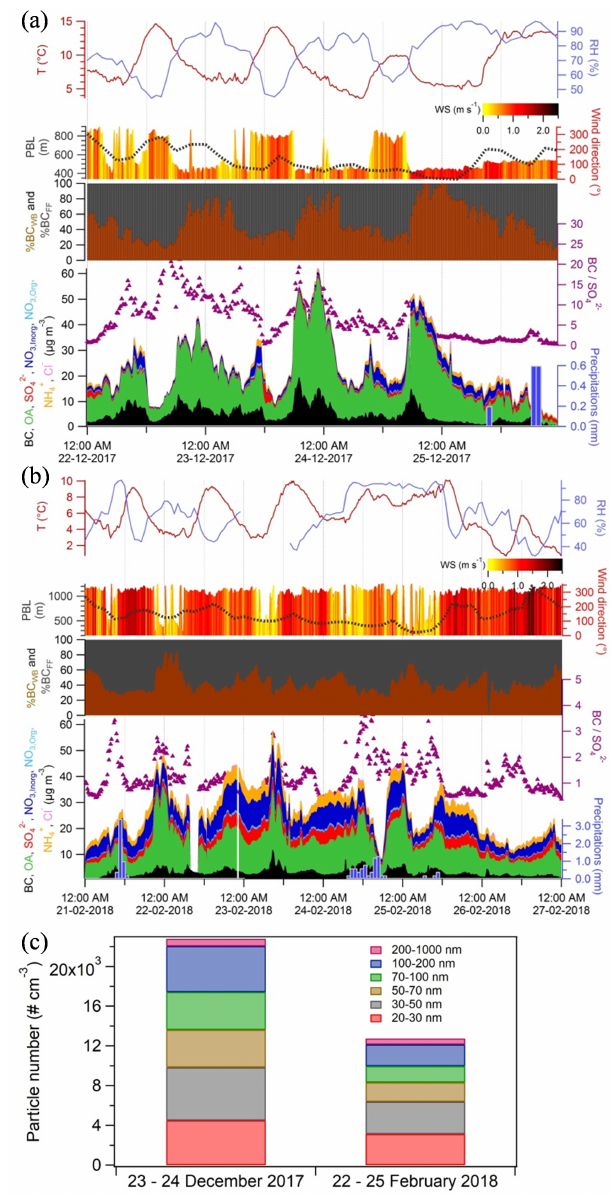
Figure 7. Time series of meteorological conditions and chemical composition during the two polluted episodes: the local Christmas event (23–24 December 2017) (a) and the long-range event (22– 25 February 2018) (b) . The chemical composition of submicron particles (Cl − , NH + , NO 3 , Org , NO 3 , Inorg , SO 2 − , OA and BC), the 4 4 relative contribution of BC FF and BC WB , the BC / SO 2 − ratio, and 4 the meteorological data (temperature, relative humidity, wind di- rection and speed, planetary boundary layer and precipitations) are represented. The size contributions of total particle number during the two events (measured with the TSI 3031) are also shown (c)